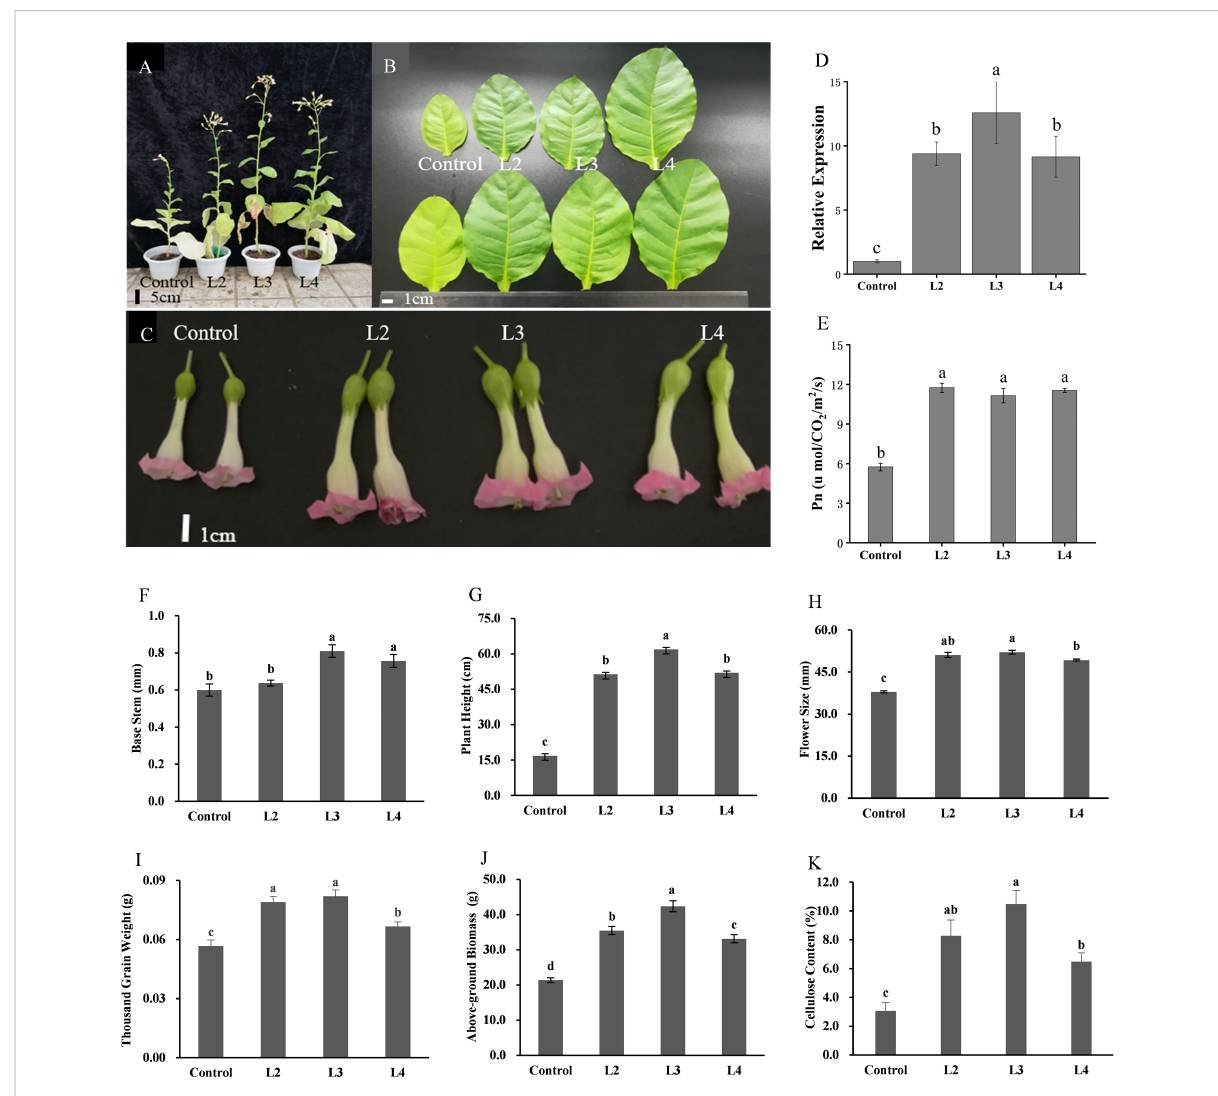
FIGURE 6 Morphological phenotypes, statistics, and above-ground biomass/cellulose content of control and three transgenic N. tabacum lines. (A) 3- month-old plants. (B) Leaf blades of 2-month-old plants. (C) Phenotype of the fl ower. (D) Relative expression of DfSUT4 in transgenic N. tabacum . (E) Net photosynthetic reaction rate of control and transgenic lines. (F – I) Morphologic index of control and transgenic lines. (J, K) Above-ground biomass and cellulose content of control and transgenic lines. Data are expressed as the mean ± SD from six independent experiments. The P -values of Student ’ s test for control and transgenic lines are denoted with letters ( P < 0.